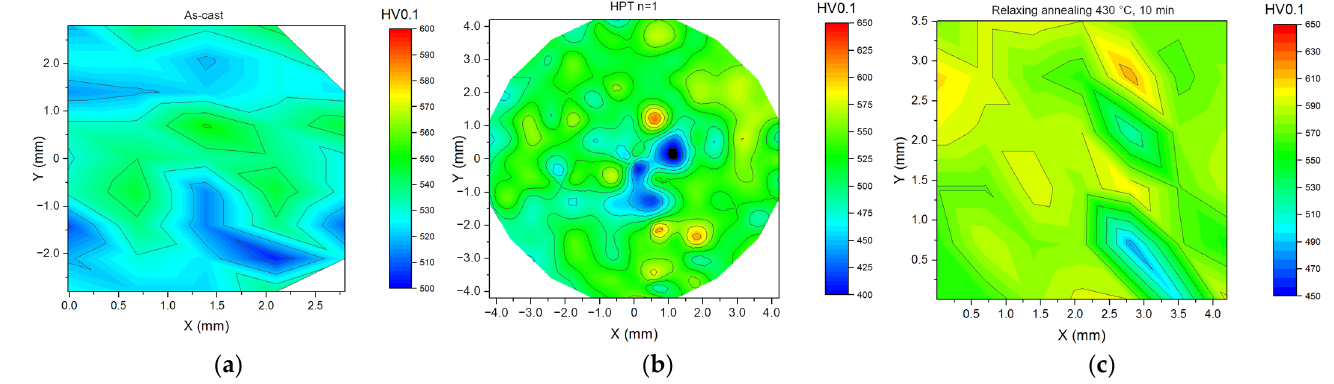
Figure 3. Microhardness distribution: ( a ) in the initial sample; ( b ) after HPT n = 1; ( c ) after relaxing annealing at 430 °C, 10 min.